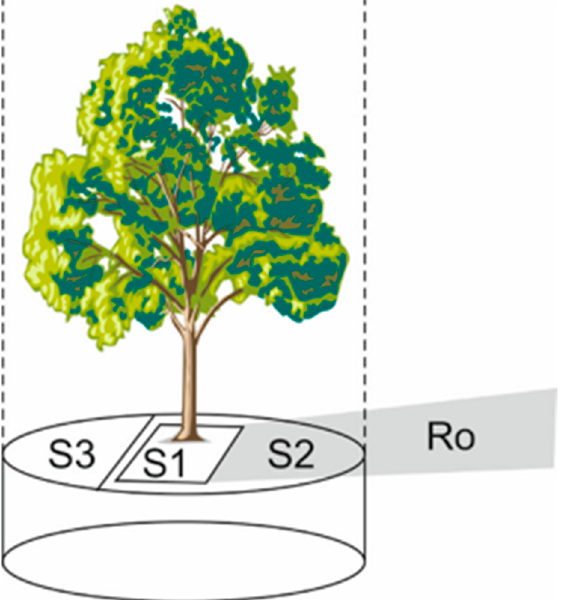
Figure 7. Scheme for surface runoff (R o ), which either can be a loss or a gain for the tree pit. Lysimeter studies and infiltration measurements of various urban areas show that Ro varies to a great extent, depending on the percentage of gaps among the pavement materials, rainfall intensity, and the age of the pavement. During the aging of the pavement, dust input reduces the infiltration and thus increases runoff [50,52–54].